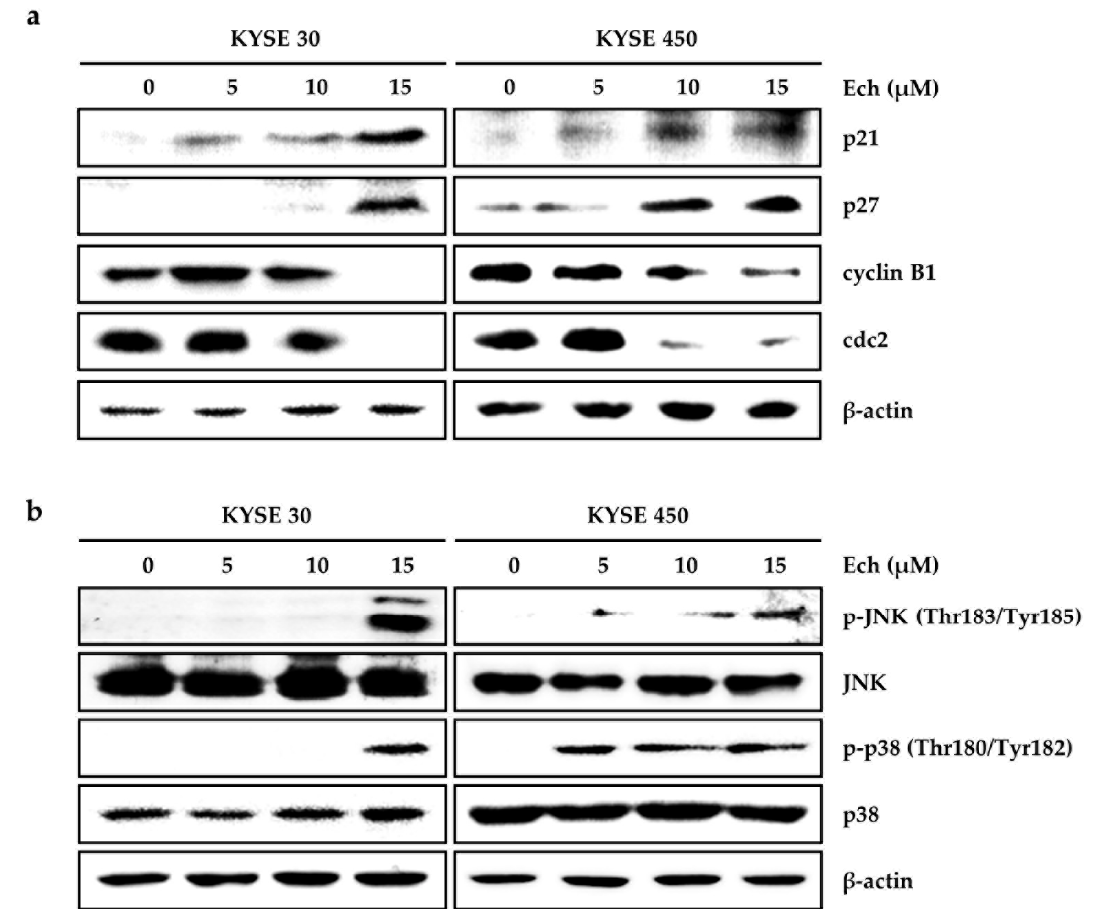
Figure 3. Effects of Ech on cell cycle and cell death related signals. ( a ) Ech induced p21 and p27 expression but decreased cyclin B1 and cdc2 expression. ( b ) Ech induced p-JNK and p-p38 expression, although total proteins levels of JNK or p38 were not changed. KYSE 30 and KYSE 450 cells were treated with Ech (0, 5, 10, 15 µM) for 48 h. The expression was examined with Western blot. β -actin was used as a loading control.